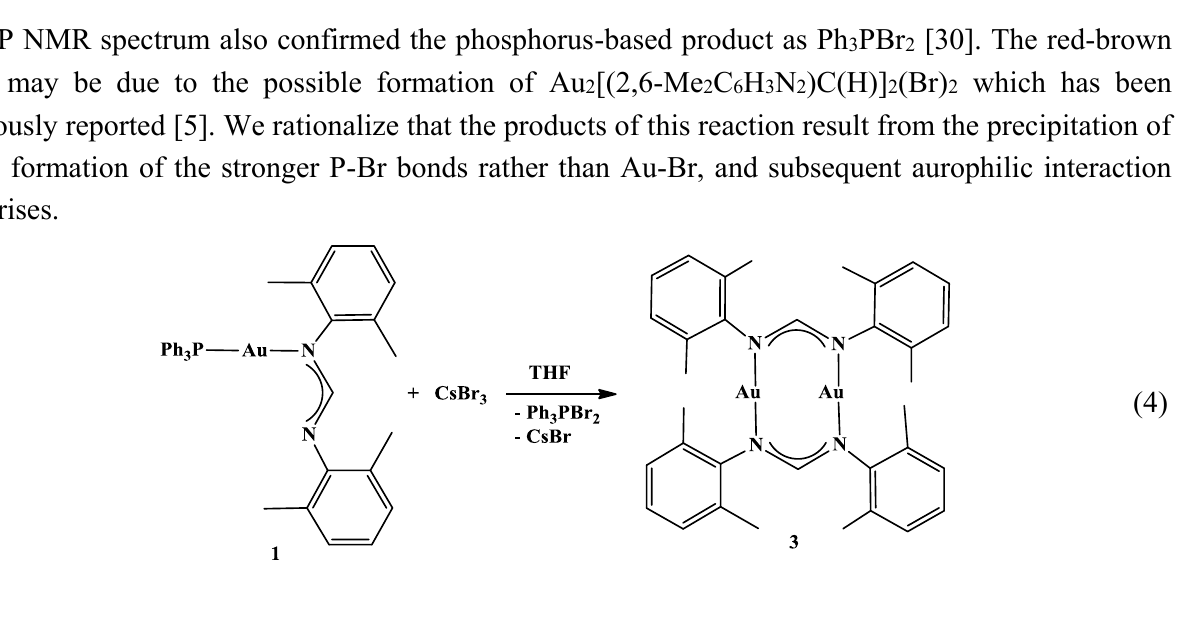
Figure 2. Thermal ellipsoid plot of 2 shown at the 50% probability level. The hydrogen atoms have been omitted for